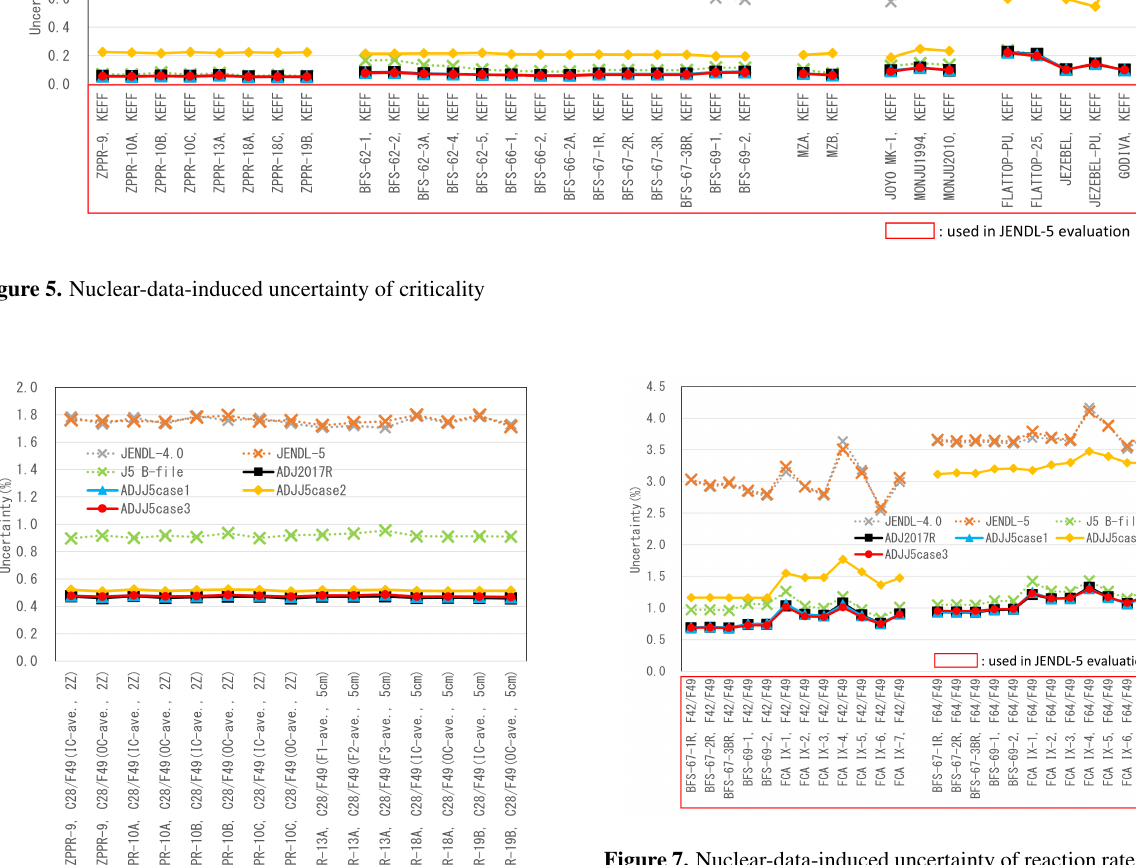
Figure 7. Nuclear-data-induced uncertainty of reaction rate ratio of F42 / F49 and F64 /